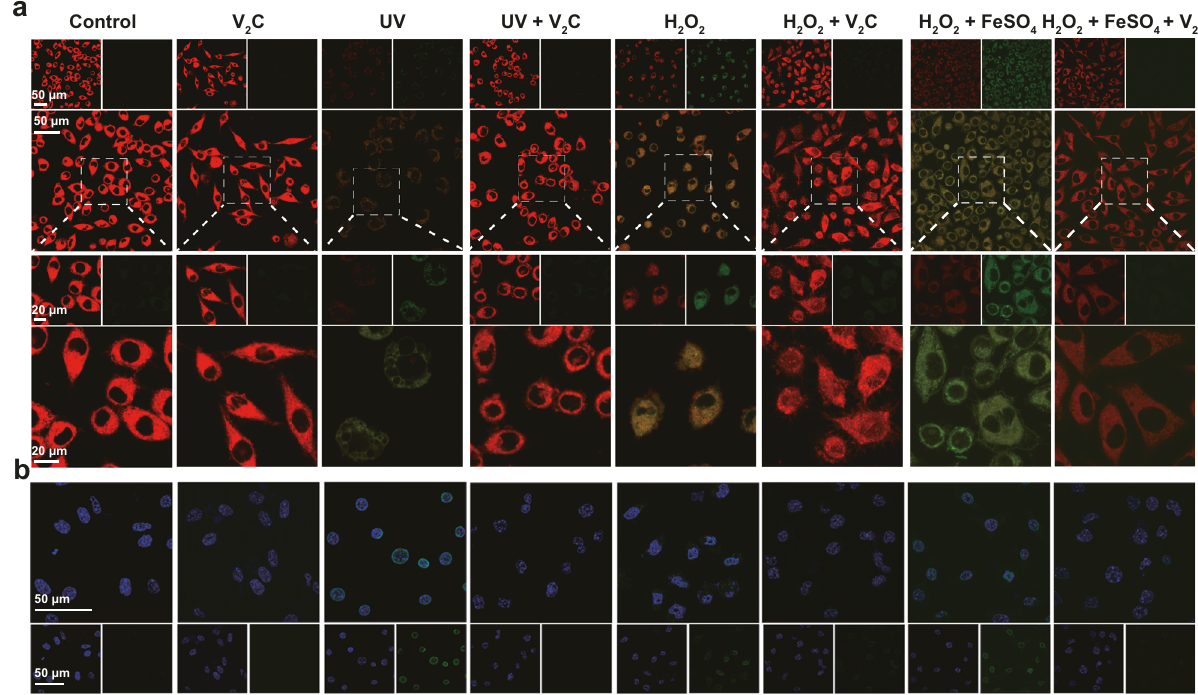
Fig. 8 Protection of cellular components from ROS-induced damage by V 2 C MXenzyme. a CLSM image of lipid peroxidation of C11-BODIPY 581/591 - stained L929 cells after different treatments. b Representative immuno fl uorescence CLSM images of γ H2AX DNA damage foci in L929 cells after different treatments. A representative image of three replicates from each group is